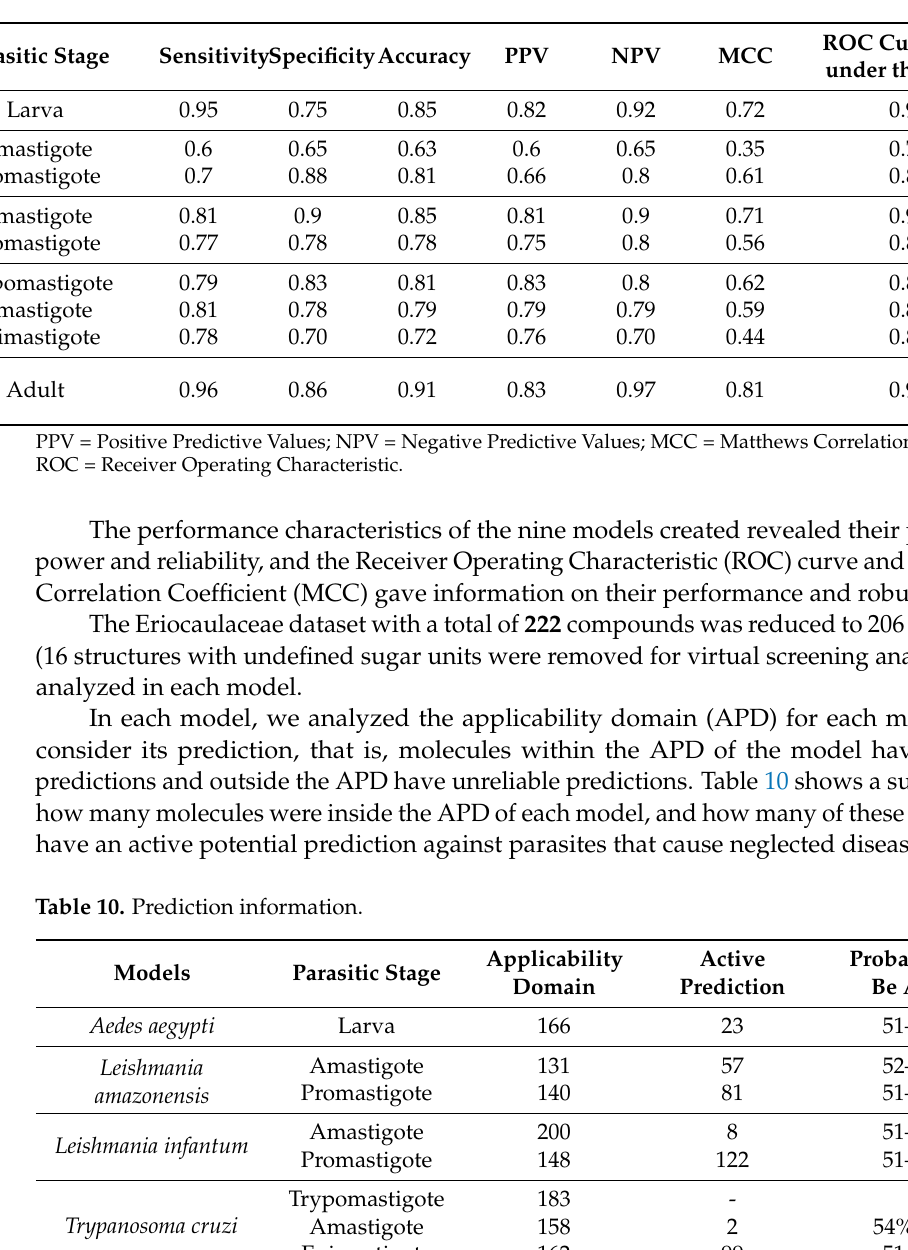
Table 9. Summary of the parameters of the results obtained in the RF models.